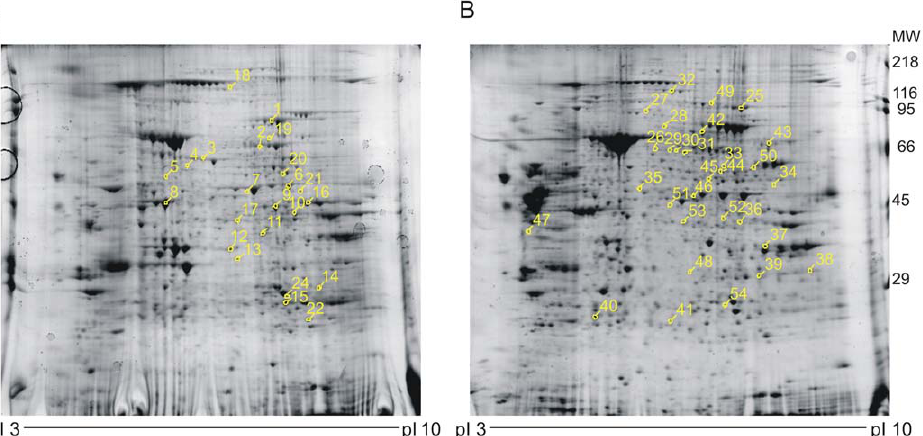
Figure 1. Two-dimensional PAGE gels analysis of PF4-DLR treated glioblastomas. In order to identify protein expression changes in mice treated with PF4-DLR, samples of treated and untreated glioblastomas were analyzed by means of two-dimensional PAGE gels. The tissues were prepared as described in Materials and Methods: 900 m g of protein underwent two-dimensional PAGE using a first dimension pH NL gradient of 3- 10% and a second dimension gradient of 9–16% acrylamide. The gels were stained with colloidal Coomassie blue. A) example of gel obtained from glioblastomas treated with PF4-DLR for 10 days; B) example of gel obtained from glioblastomas treated with PF4-DLR for 20 days. At least seven gels per condition were used to analyze protein changes. The analyzed spots and related identification numbers are shown in yellow.